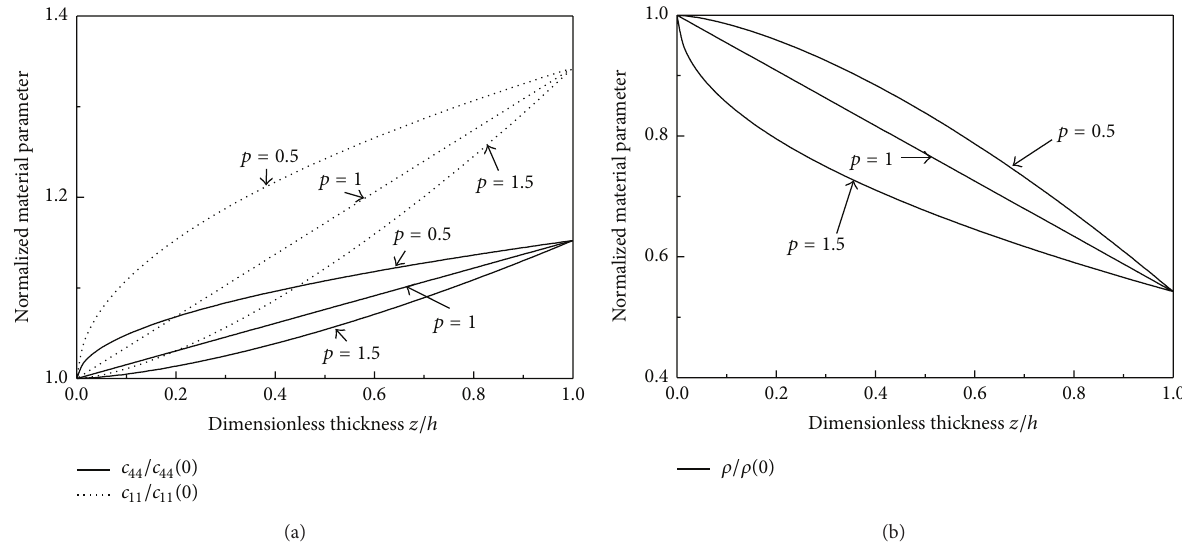
Figure 2: Profiles of material parameters: (a) normalized elastic parameter 𝑐 11 /𝑐 11 (0) and 𝑐 44 /𝑐 44 (0) and (b) normalized density 𝜌/𝜌(0) .